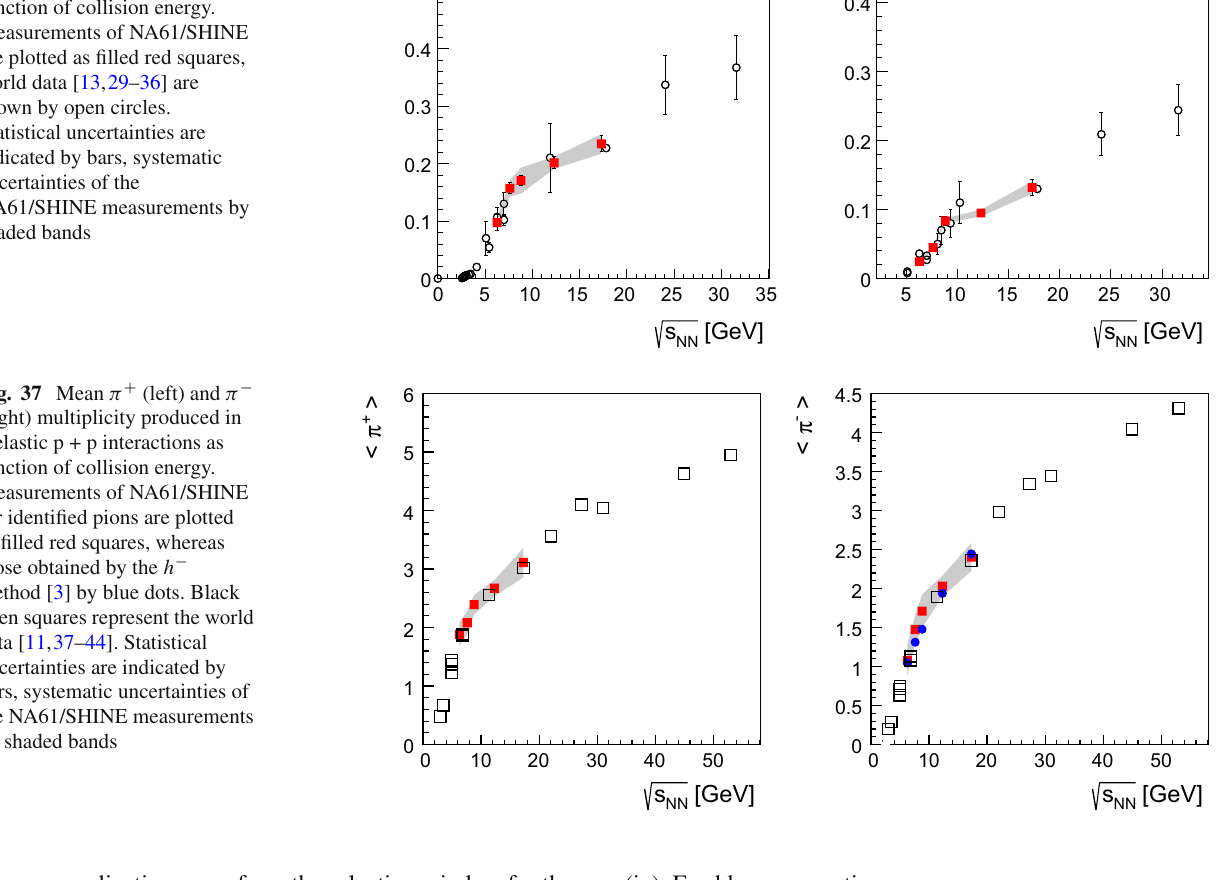
Fig. 36 Mean K + (left) and K − (right) multiplicity produced in inelastic p + p interactions as function of collision energy. Measurements of NA61/SHINE are plotted as filled red squares, world data [13,29–36] are shown by open circles. Statistical uncertainties are indicated by bars, systematic uncertainties of the NA61/SHINE measurements by shaded bands